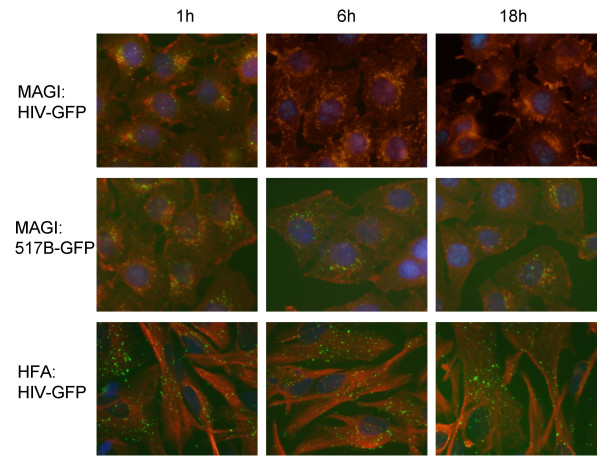
Dynamics of GFP-Vpr/HIV-1 association with HFA or MAGI cells at 37°C. MAGI cells were exposed to NL4-3 carrying GFP-Vpr (first row) or to the fusion incompetent HIV-1/517B carrying GFP-Vpr (second row) or HFA were exposed to NL4-3-GFP-Vpr. Cells were incubated with virus at 37°C and fixed at 1 h (first column), 6 h (second column), or 18 h (third column) after infection. HeLa cells were stained with anti-actin and HFA were stained with anti-GFAP, with DAPI and with Texas Red-labeled secondary antibodies. Images shown are superimpositions of red and green fluorescence.